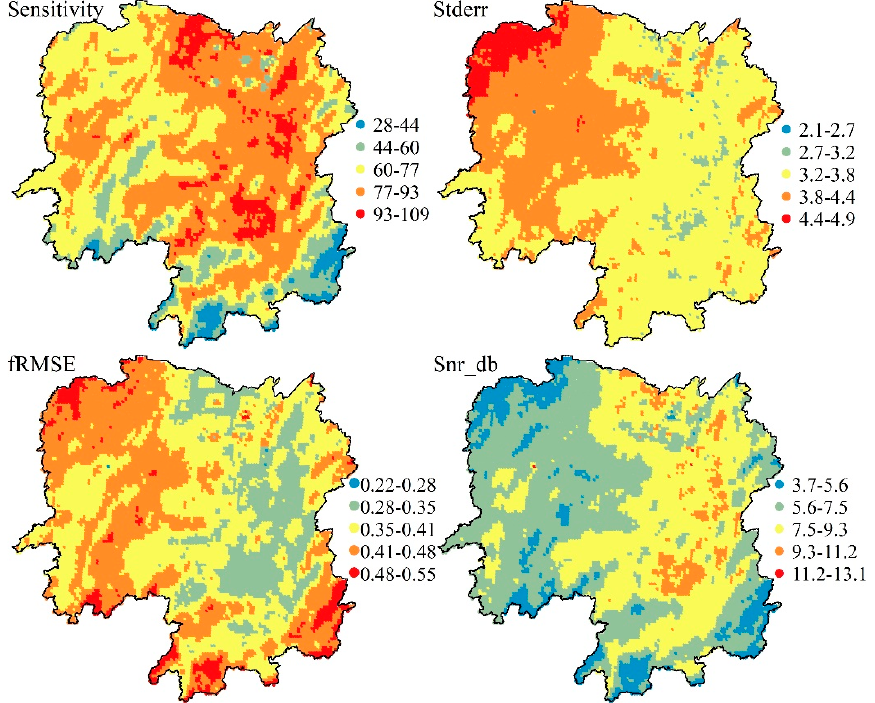
Figure 5. Distribution of TCA error indicators for FY-4A LST in Hunan Province; results are shown only for grids in which all three datasets showed significant positive correlation and there were >100 triplets.